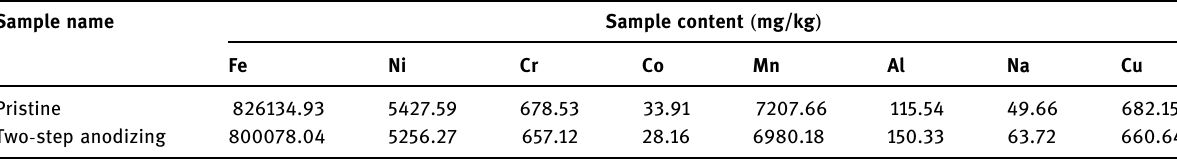
Table 1: The ICP - MS results of the pristine and after the two - step anodized samples Sample